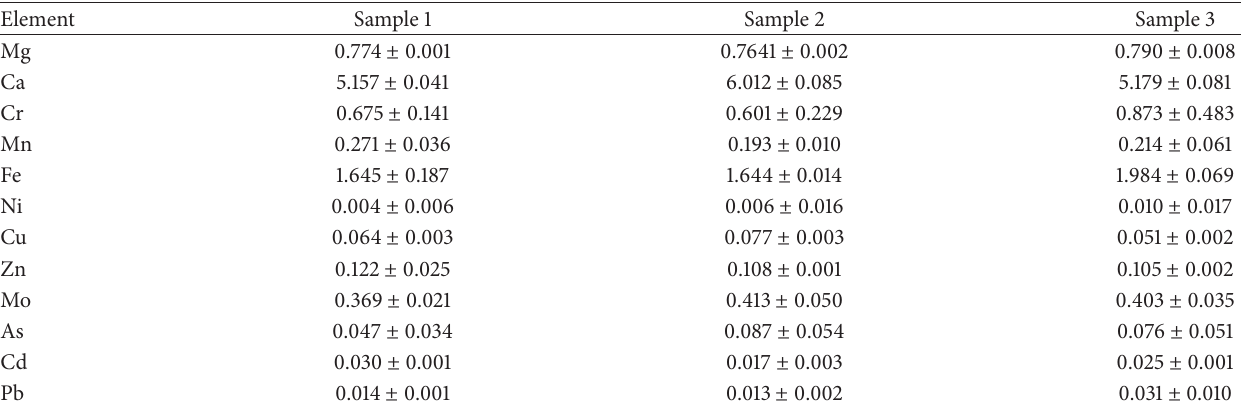
Table 2: Distribution levels (mg/kg ± SD) of elemental contents in the triplicate samples of Cymbopogon citratus plant (mean values ± SD).